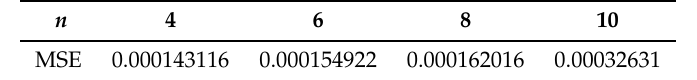
Table 15. n Selection for PCAR.